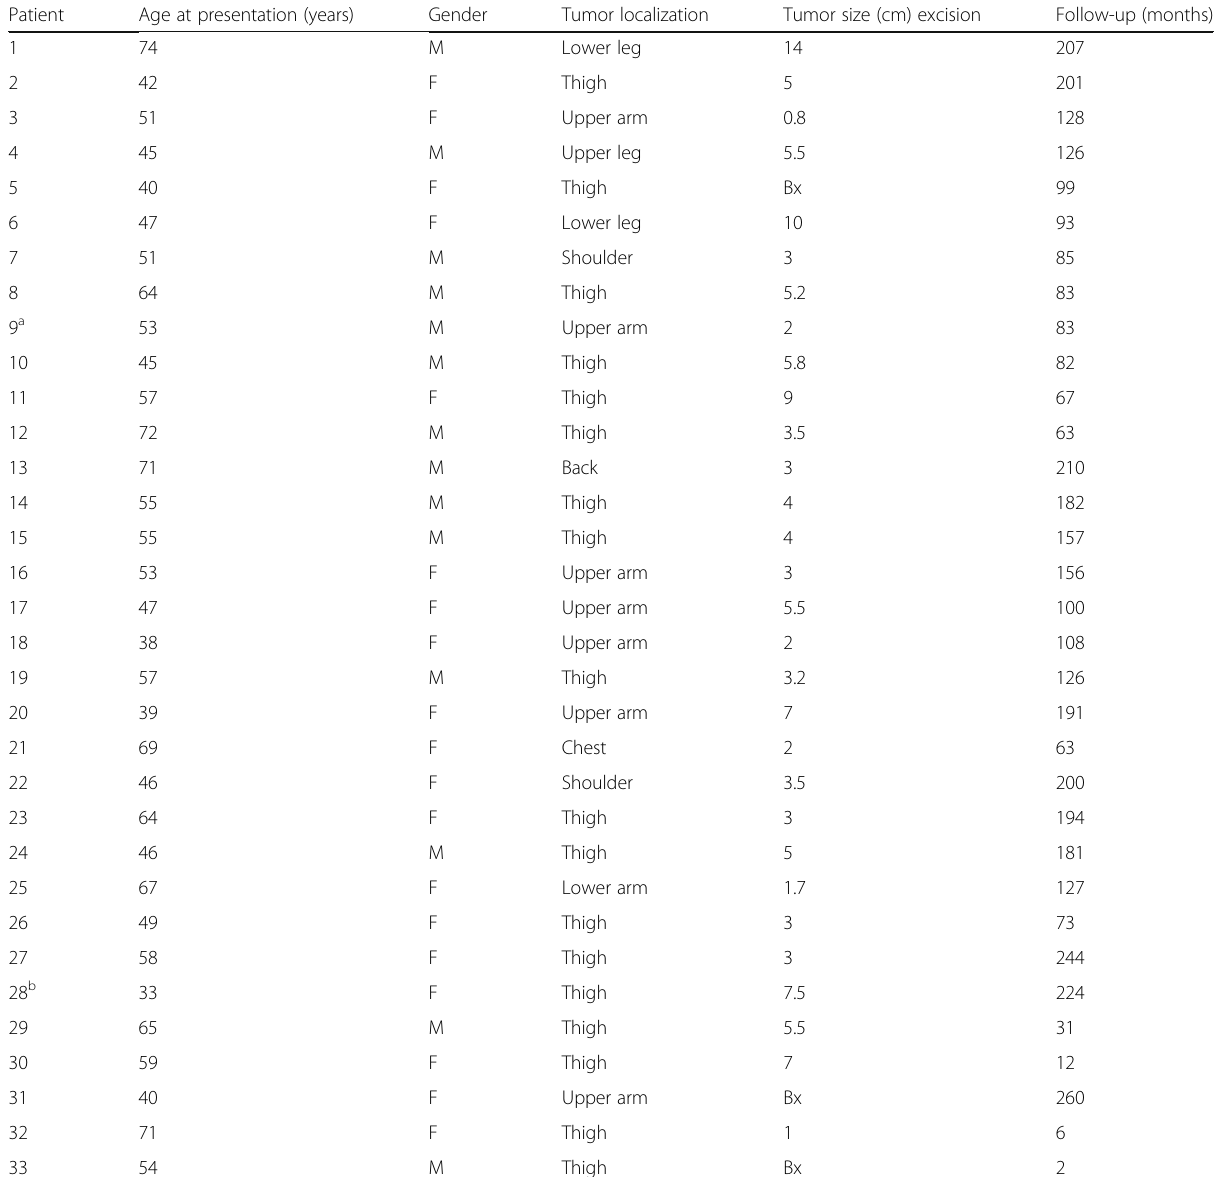
Table 2 Patient